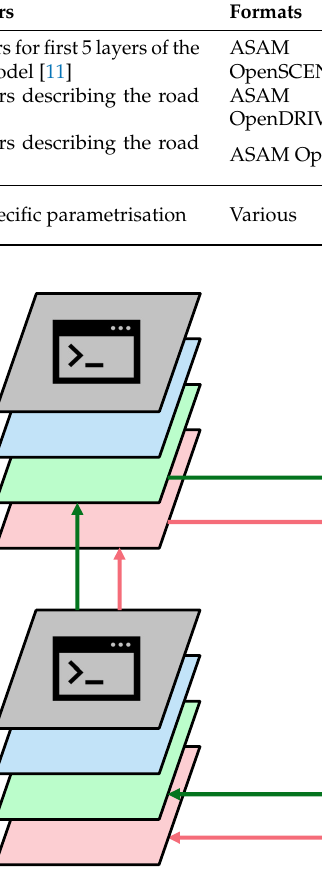
Figure 17. Overview of a proposal for the conceptual enhancement of simulation framework archi- tectures for virtual